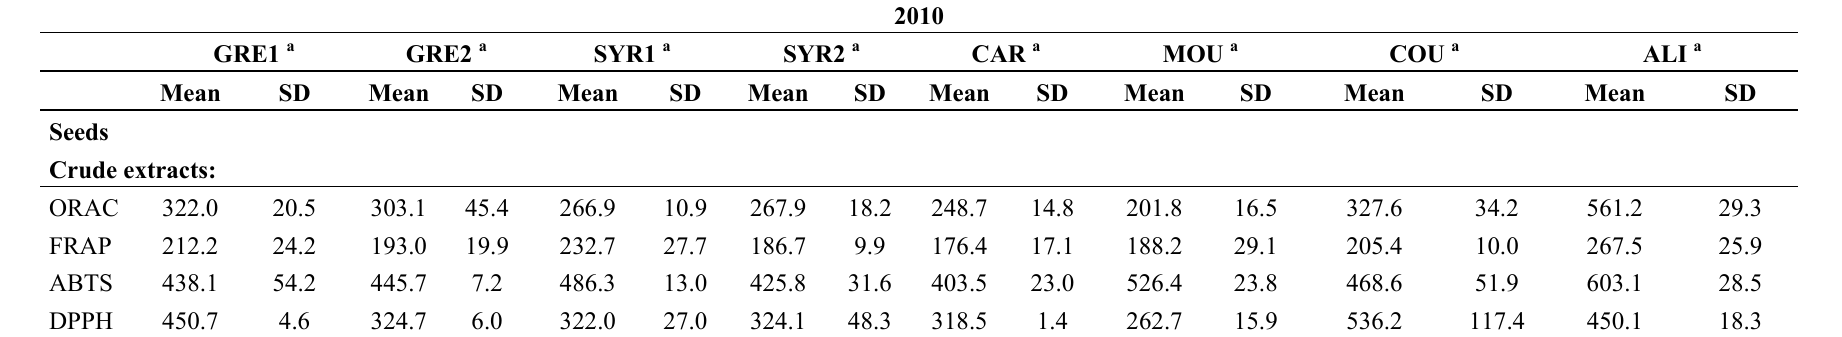
Table 6. Radical scavenging capacity of grape pomace skins and seeds in